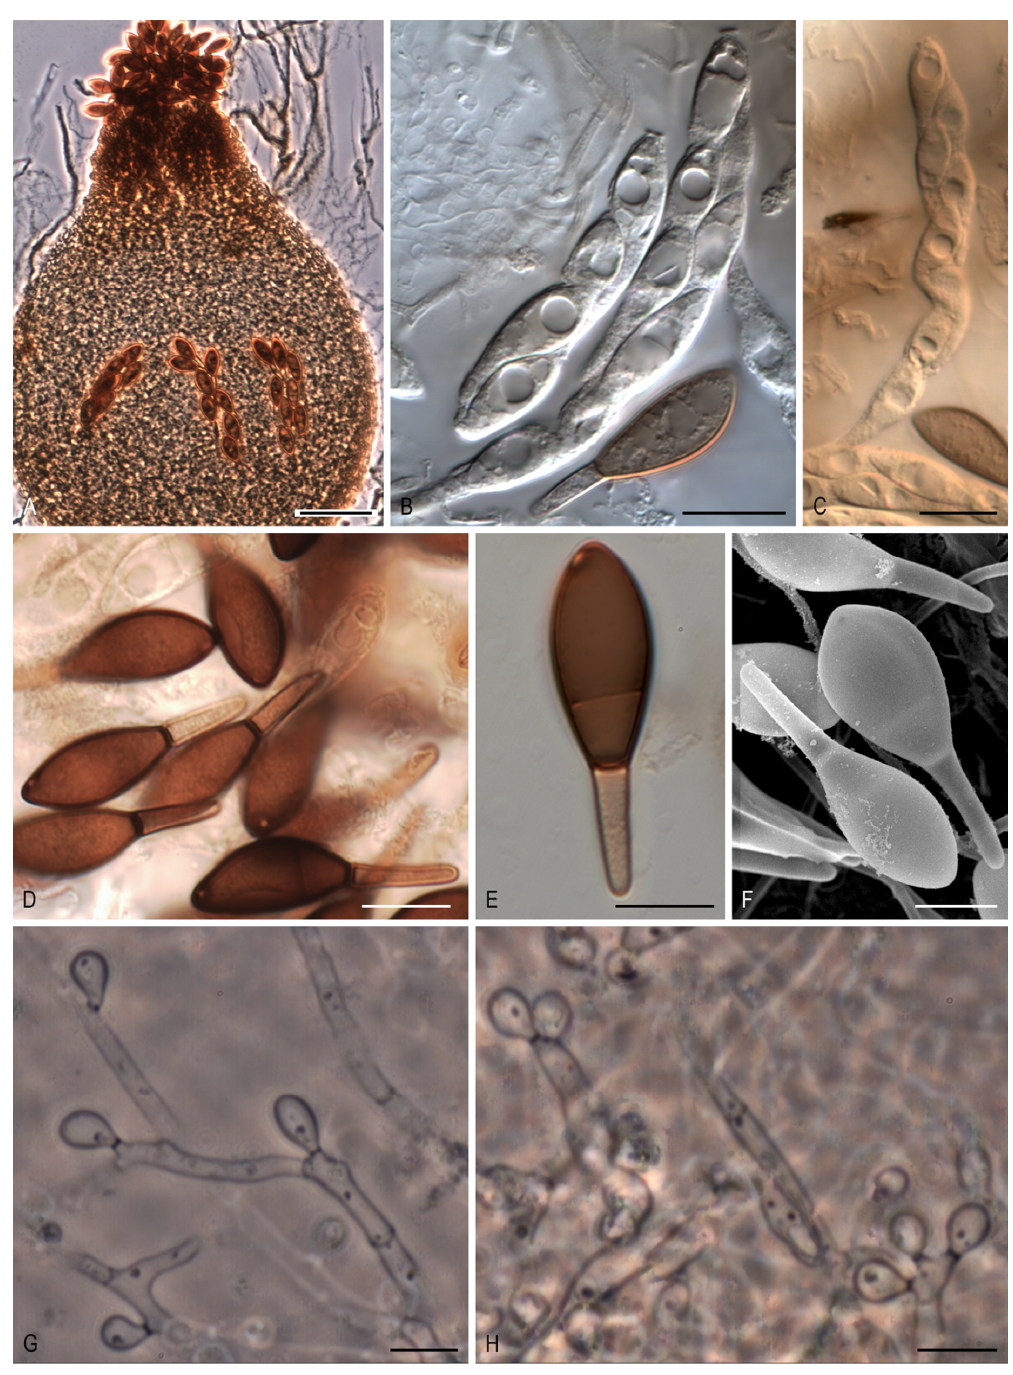
Figure 4. Naviculispora terrestris CBS 137295 T . ( A ) Ascomata. ( B , C ) Asci. ( D – F ) Ascospores. ( G ) Conidia sessile. ( H ) Conidia borne on sympodially proliferating conidiophores. Scale bars: ( A ) = 100 µm; ( B , C ) = 20 µm; ( D ) = 15 µm; ( E , F ) = 10 µm; ( G , H ) = 5 µm. Reference strains of P. cochleariformis , P. decipiens, P. myriaspora , and P. pleiospora , classified by Lundqvist [9] into the section Rhypophila of the genus Podospora , formed a well-supported clade (100% bs/ 1 pp) in the Naviculisporaceae. All four species are characterized by the production of an ascomatal neck with elongate tuberculated projections at the base, asci usually with more than eight